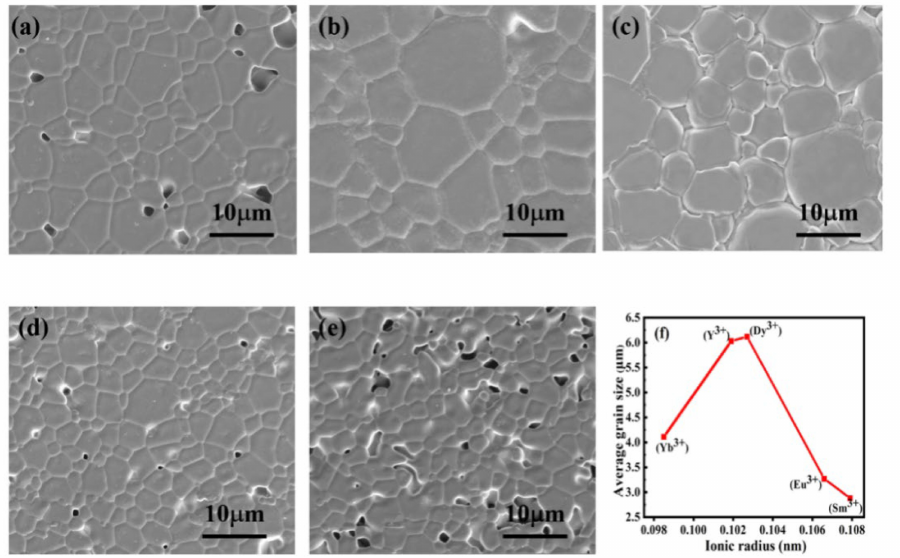
Figure 3. SEM images of Y 2.95 R 0.05 MgAl 3 SiO 12 ceramics: ( a ) Yb; ( b ) Y; ( c ) Dy; ( d ) Eu; ( e ) Sm; ( f ) the average grain size as a function of ionic